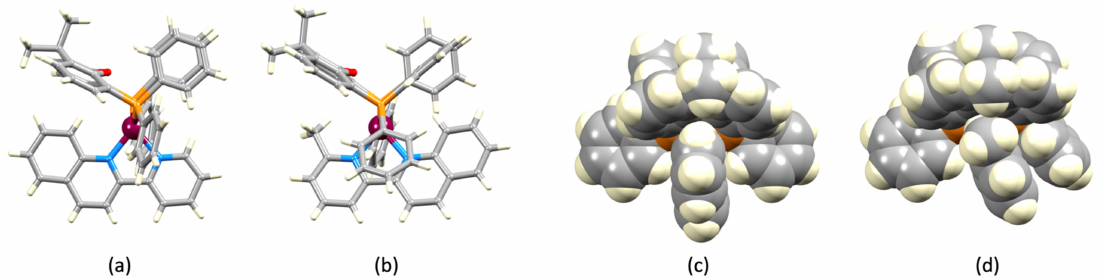
Figure 7. Views of the ( a ) [Cu(xantphos)( 1 )] + and ( b ) [Cu(xantphos)( 2 )] + cations illustrating the di ff erent orientations of 1 and 2 with respect to the xanthene unit. Spacefilling representations of ( c ) [Cu(xantphos)( 1 )] + and ( d ) [Cu(xantphos)( 2 )] + looking towards the xanthene ‘bowl’ (top of the